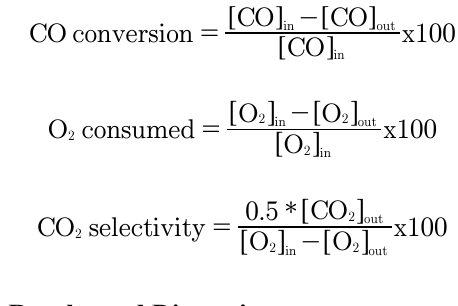
Table 1. EDX analysis of Au/TiO Route